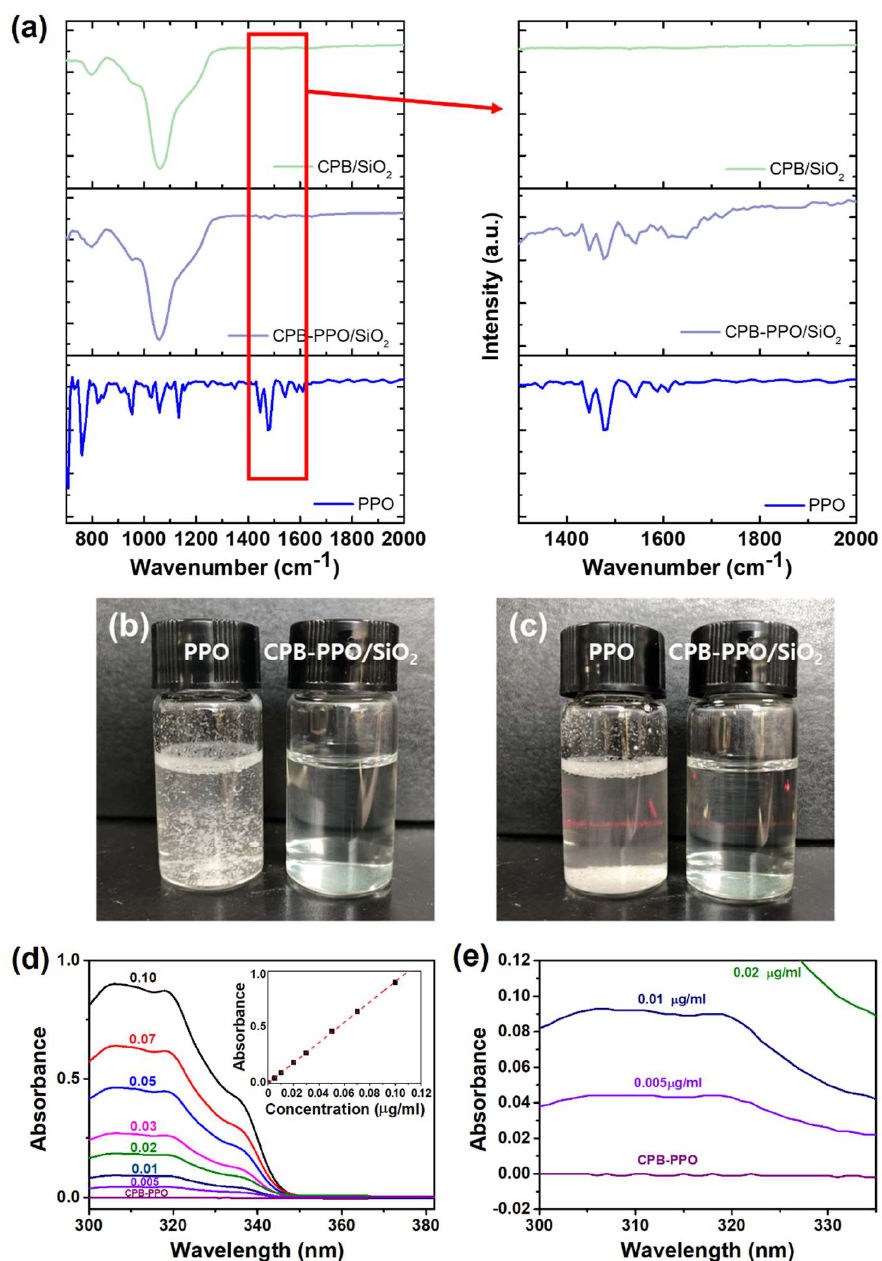
Figure 2. ( a ) Fourier-transform infrared (FTIR) spectra of CPB/SiO 2 NPs, CPB–PPO/SiO 2 NPs, and PPO molecules (from top to bottom). The magnified spectra over the wavenumber region of aromatic C=C vibration (1400–1600 cm − 1 ) are also shown on the right to confirm the embedment of PPO molecules in the CPB/SiO 2 NPs. ( b , c ) Photographs of PPO molecules and CPB–PPO/SiO 2 NPs dispersed in water, taken immediately ( b ) and 1 h after the dispersion ( c ). ( d , e ) Electronic absorption spectra of the solution containing CPB-PPO/SiO 2 NPs and solutions containing various concentrations of PPO in tolutene at the 300–380 nm ( d ) and 300–335 nm ( e ) wavelength region. The plot of absorbance vs. PPO concentration and the calibration curve are shown in the inset of ( d ).